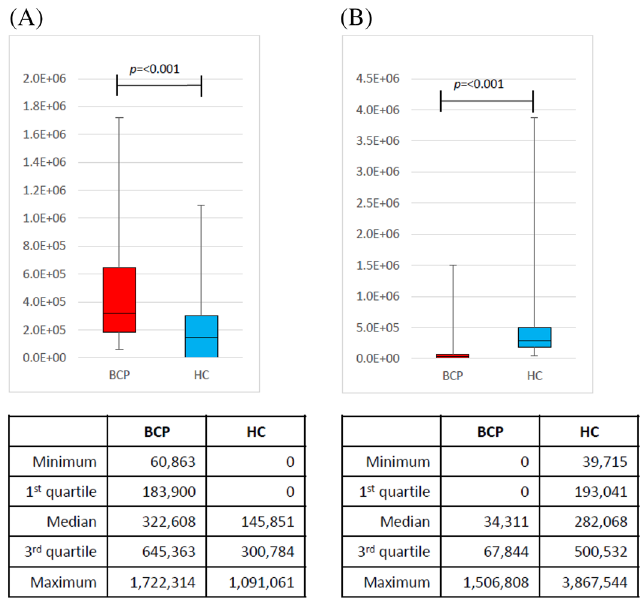
Figure 4. Box charts of the peak areas of the 2-butanone and 2-propanol of the external validation set using the model. Box plots of the peak areas of 2-propanol and 2-butanone in the external validation set using the model. The peak areas in the external validation set were similar to those in the training set. ( A ) Peak areas of 2-butanone and ( B ) 2-propanol. BCP breast cancer patient, HC healthy